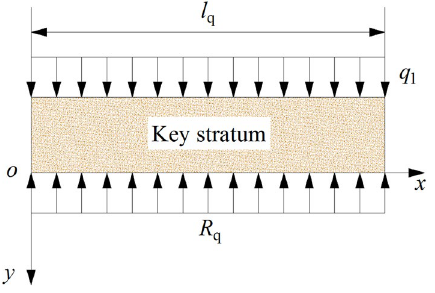
Figure 10. The mechanical model of key stratum in